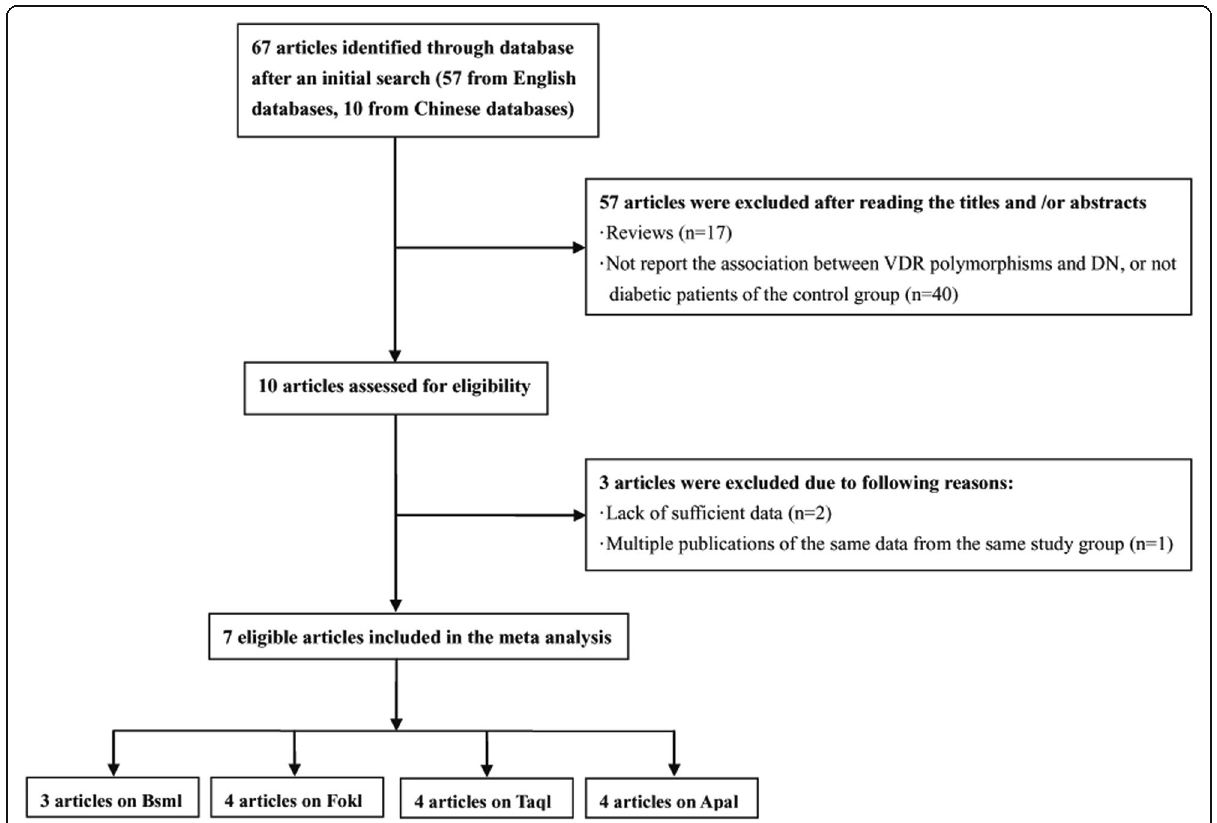
Fig. 1 Flow diagram of included and excluded